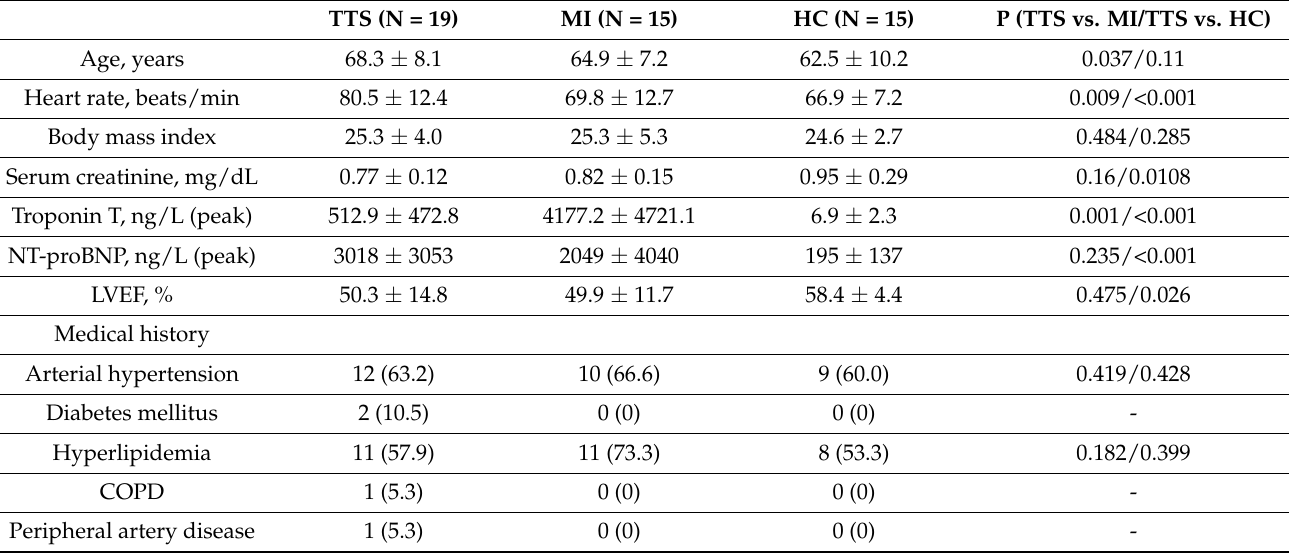
Table 1. Sample characteristics of HC, as well as TTS and MI patients at baseline. Distributions of demographic and clinical data for participants are presented as means ± standard deviation or median ± interquartile range. TTS: takotsubo syndrome, MI: myocardial infarction, HC: healthy controls. TTS (N = 19) HC (N = 15) P (TTS vs. MI/TTS vs. HC)